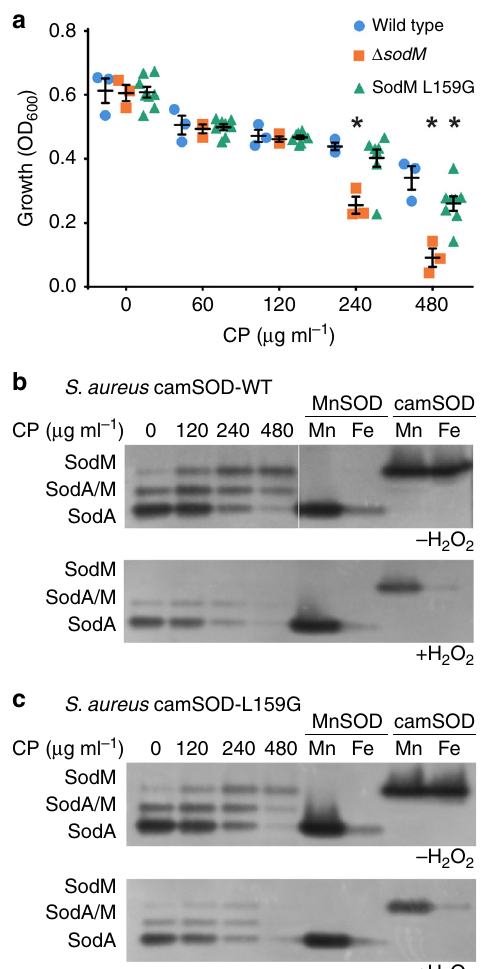
Fig. 6 Iron-dependent camSOD activity enables S. aureus to resist host stresses. a The Δ sodM mutant strain (lacking the gene encoding camSOD- orange squares) of S. aureus shows greatly diminished growth in the presence of paraquat (PQ) relative to wild type (WT-blue circles) under manganese- depleted conditions imposed by the presence of the human protein complex calprotectin (CP) 8,16,17 . S. aureus cells expressing the Leu159Gly variant of camSOD from the native sodM locus (green triangles) also show reduced growth relative to the wild type. Note that the asterisk represents p <0.05 via two-way ANOVA with Tukey ’ s post-test performed in Graphpad Prism when compared to wild-type bacteria grown in the same concentration of calprotectin. Multiple independent clones of the Leu159Gly variant ( n = 8) were assayed at the same time as those of the wild type ( n = 3) and the Δ sodM mutant strain ( n = 3). Each data point represents an independent biological replicate. Black bars represent the mean, with error bars showing standard error of the mean (SEM). The diminished ability of the camSOD variant to use iron (Table 1) renders S. aureus less capable of overcoming the host immune b wild type S. aureus and c the strain expressing the Leu159Gly camSOD variant, cultured under identical conditions to those used in a , demonstrate that both forms of the SodM enzyme are detectable at similar levels (upper panels). Treatment of the extracts (left) or recombinant enzymes (right) with H 2 O 2 (lower panels), a speci fi c inhibitor of the iron-loaded form 8 , demonstrated that the camSOD was loaded with iron in wild-type cells. The MnSOD enzyme is labeled as SodA, camSOD as SodM. This is a representative gel from a triplicate analysis of independent biological replicates ( n = 3). Note that molecular weight markers were not used in these native gels, with SOD bands identi fi ed in the cell extracts by comparison of their mobility with the puri fi ed recombinant proteins. Source data for all panels are provided as a source data fi